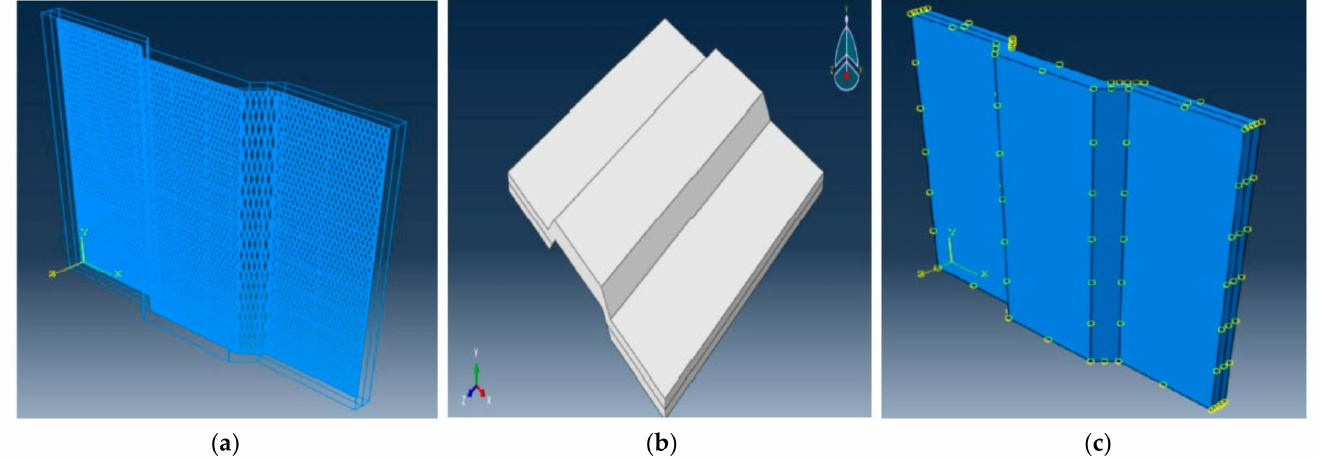
Figure 22. ( a ). Assigning Mesh Detailing, ( b ). Assigning Mortar Property, and ( c ) Assigning Bound- ary